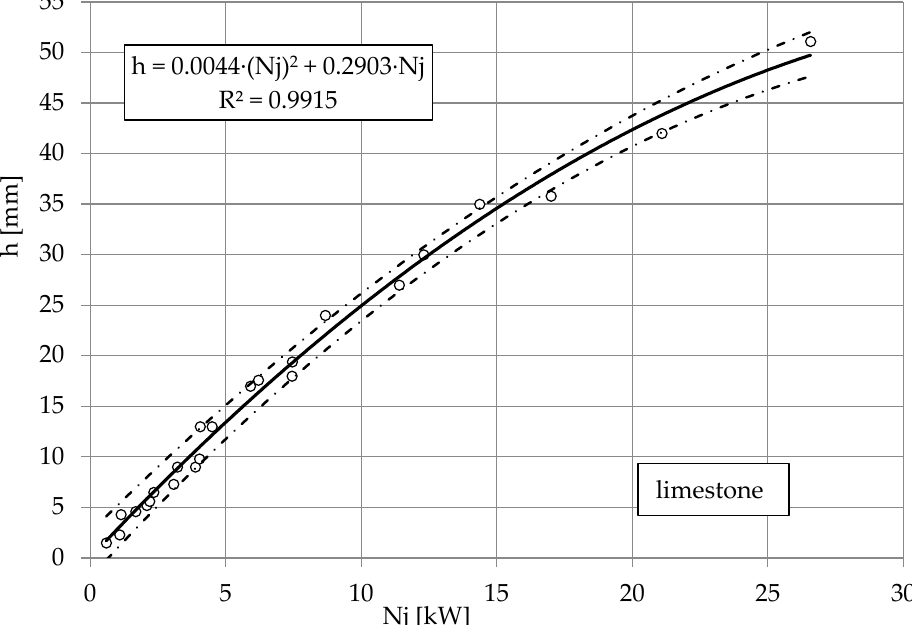
Figure 8. Influence of jet power Nj on cutting depth h of limestone, with abrasive waterjet: feed speed v p = 3 mm · s − 1 , abrasive flow rate m a = 6.7 g · s − 1 .